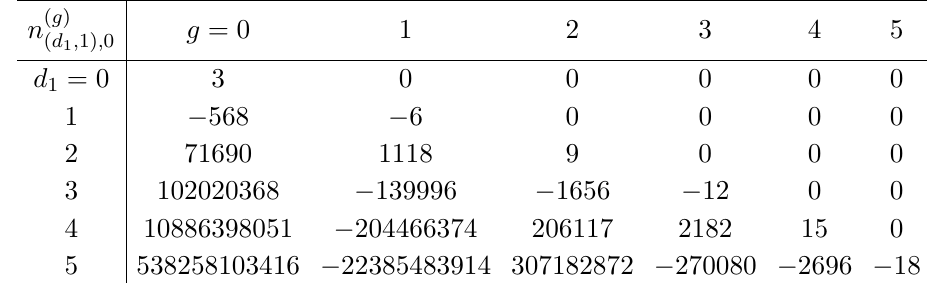
Table 8 . Torsion refined Gopakumar-Vafa invariants at base degree one with Z 2 charge 0 .